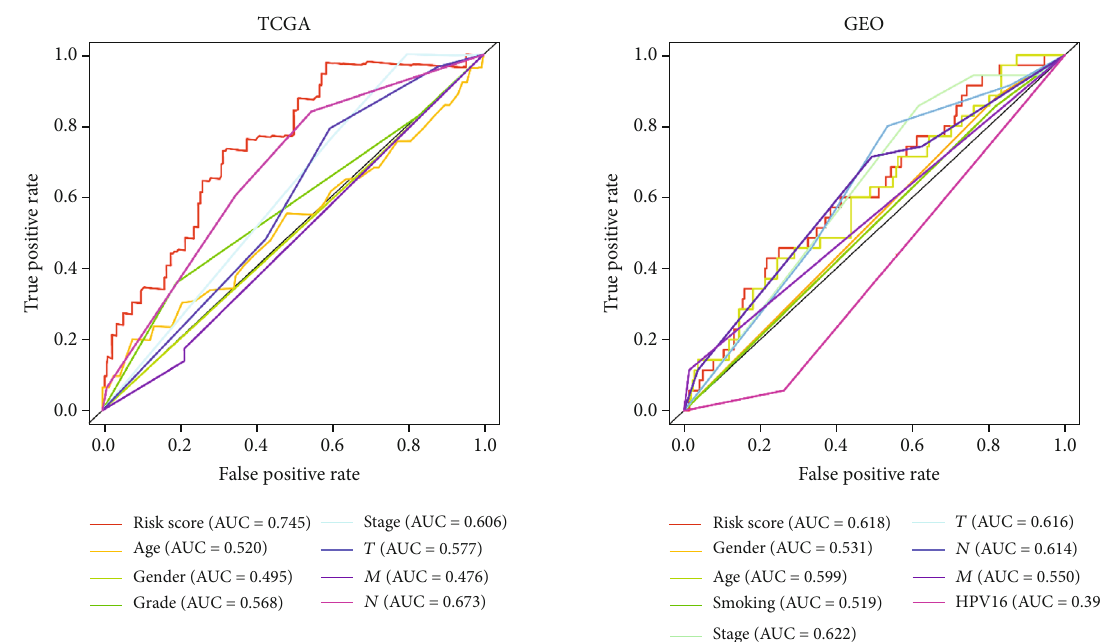
Figure 4: The predictor of clinicopathological in HNSCC was also analyzed, and we found the AUC for age, gender, grade, stage, T, M, and N was 0.520, 0.495, 0.568, 0.606, 0.577, 0.476, and 0.673, respectively, in TCGA, and the AUC for age, gender, stage, T, M, N, smoking, and HPV16-pos was 0.599, 0.531, 0.622, 0.606, 0.616, 0.550, 0.614, 0.519, and 0.397, respectively, in